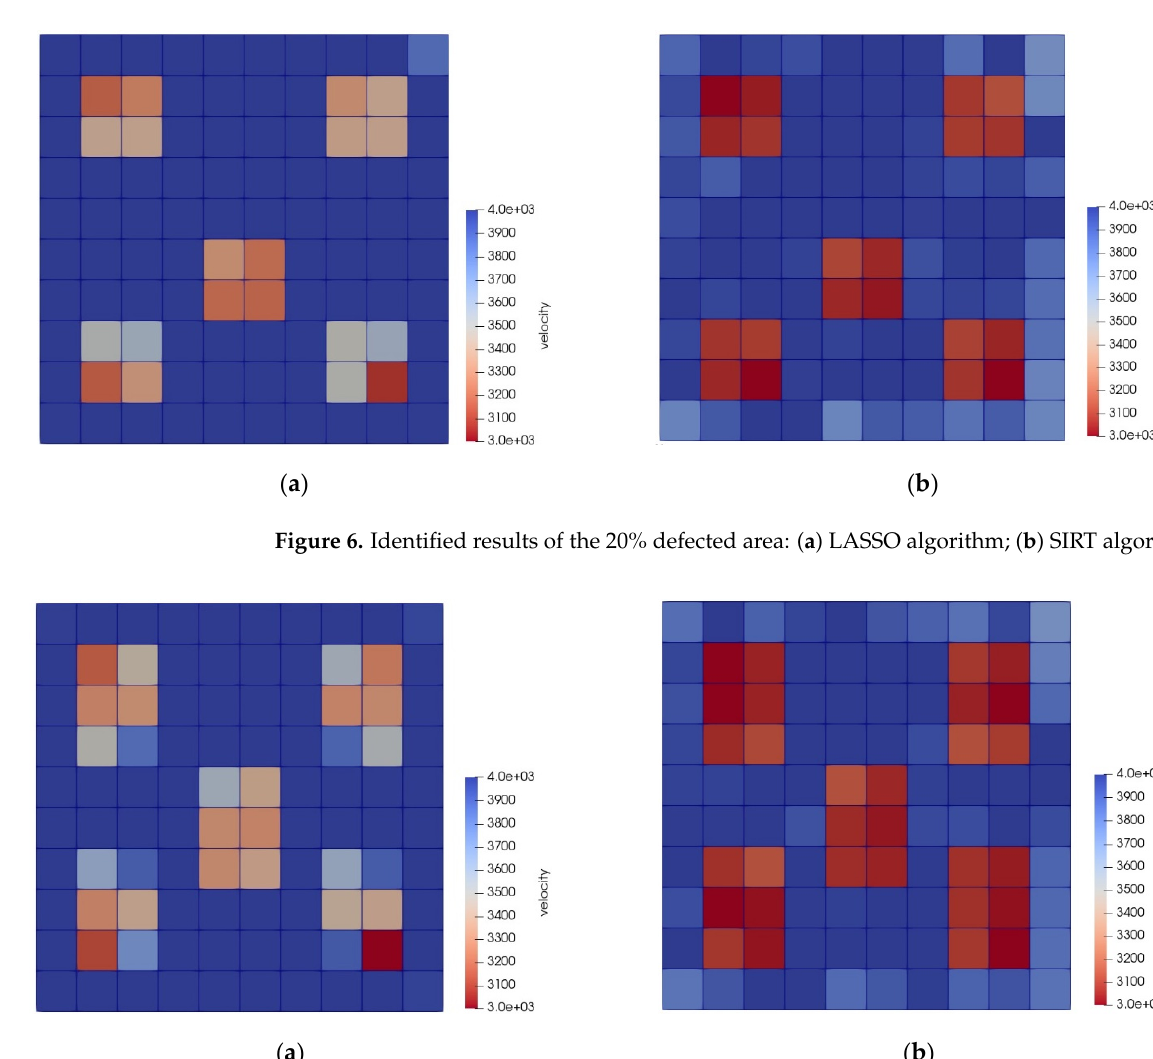
Figure 5. Identified results of the 10% defected area: ( a ) LASSO algorithm; ( b ) SIRT algorithm.